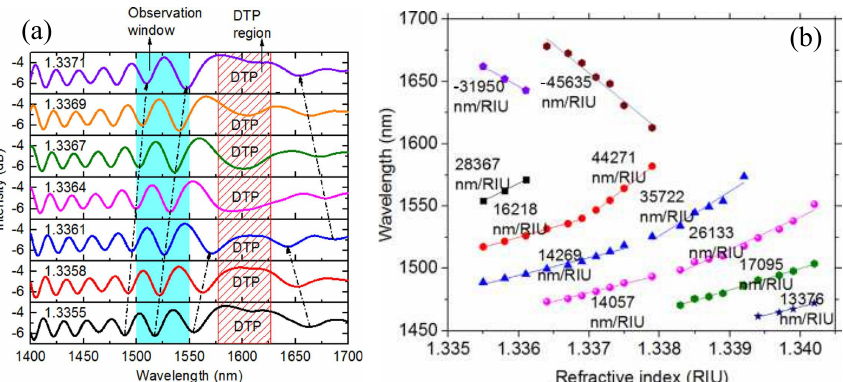
Figure 3. ( a ) Evolution of transmission spectrum of the microfiber MZI with the variation of refractive index; ( b ) RI sensitivities of interference dip around cut-off wavelength of the microfiber MZI in RI range of 1.3355–1.3402. [42]. Reprinted with permission from Ref. [42]. Copyright 2020 Elsvier Science and Technology